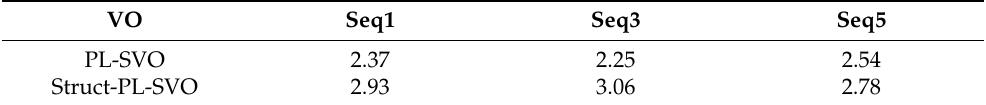
Table 4. Average runtime of the algorithm (ms); no